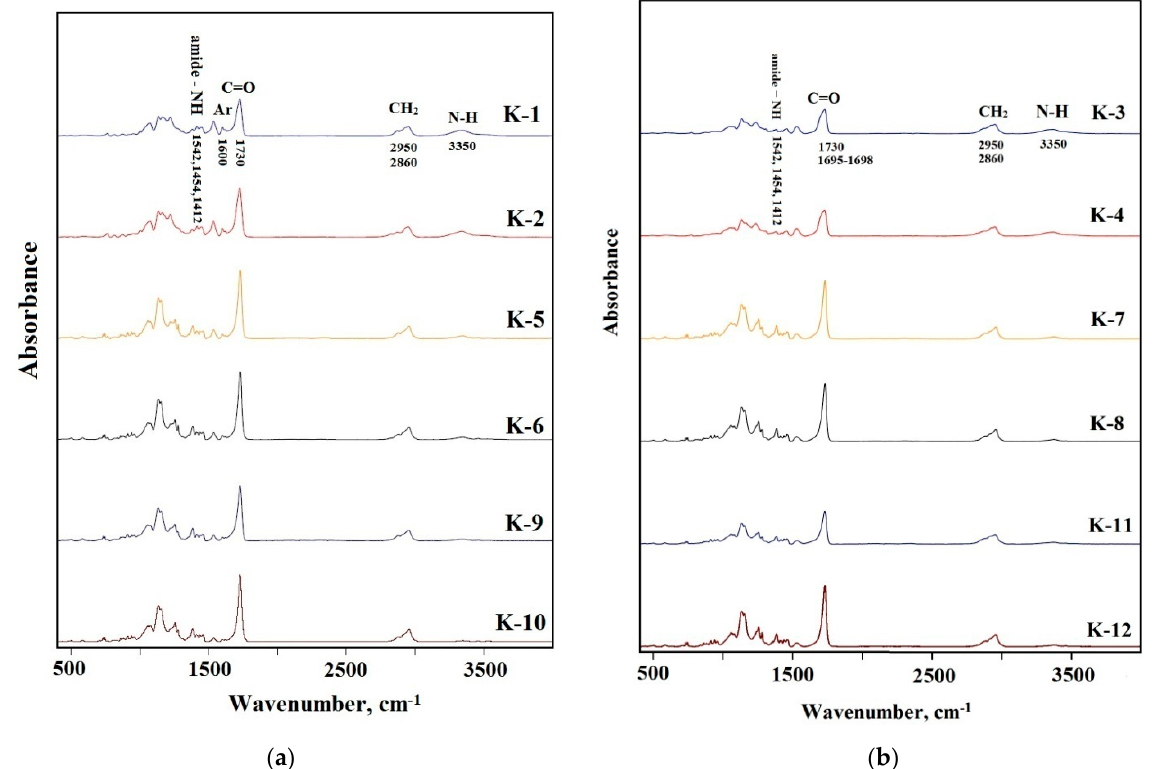
Figure 6 . The FTIR spectra for the samples: ( a ) K–1, K–2, K–5, K–6, K–9, K–10; ( b ) K–3, K–4, K–7, K–8, K–11, K–12. K–11,